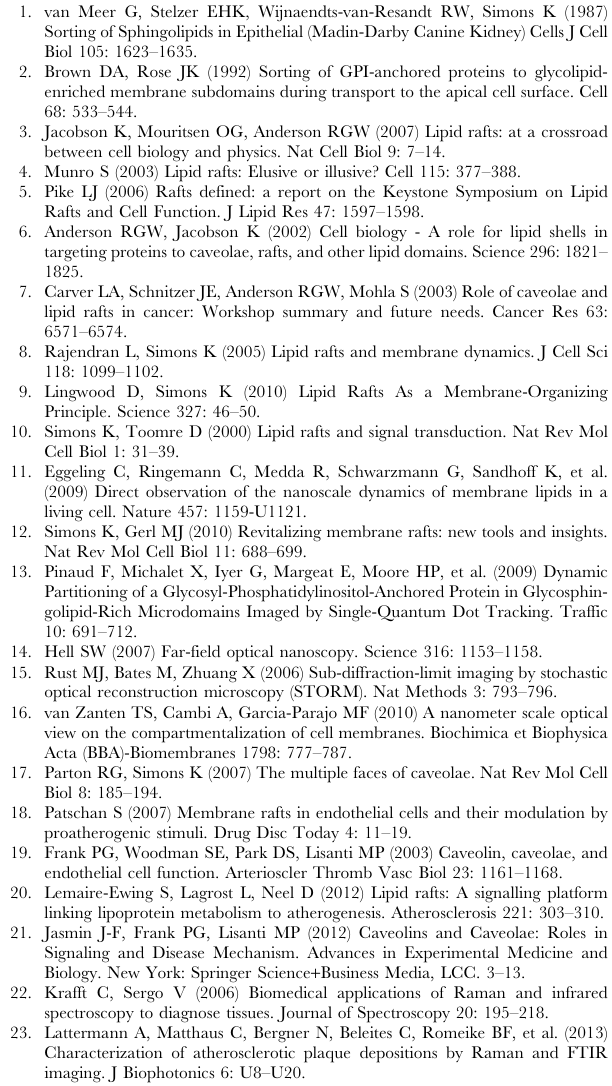
Figure S3 Endothelium area covered by lipid rafts. The Raman distribution image obtained by integration of the band in the 2800–3100 cm 2 1 range of a studied fragment of db/db sample ( A ), CA results (K-means, Manhattan distance) for a class assigned to lipid rafts ( B ), the area classified as lipid rafts counted in Image J processing program (Rasband, W.S., ImageJ, U. S. National Institutes of Health, Bethesda, Maryland, USA, http://imagej.nih. gov/ij/, 1997–2014), statistics related to calculated area of lipid rafts ( D ) with the visual representation ( E ). (TIF) Figure S4 Average lipid content in tissues from db/db and db + mice. Integral intensity of marker bands due to lipids and proteins at 2940 and 1008 cm 2 1 , respectively, in the individual samples along with the ratio of bands due to lipids and proteins ( A ), the average values for diabetic (db/db) and control mice (db + ) with the standard deviation ( B ) and the overall endothelium lipid content (defined as the average intensity ratio of the band at 2940 to the band at 1008 cm 2 1 in all measured db/db or db + samples; C ). (TIF)